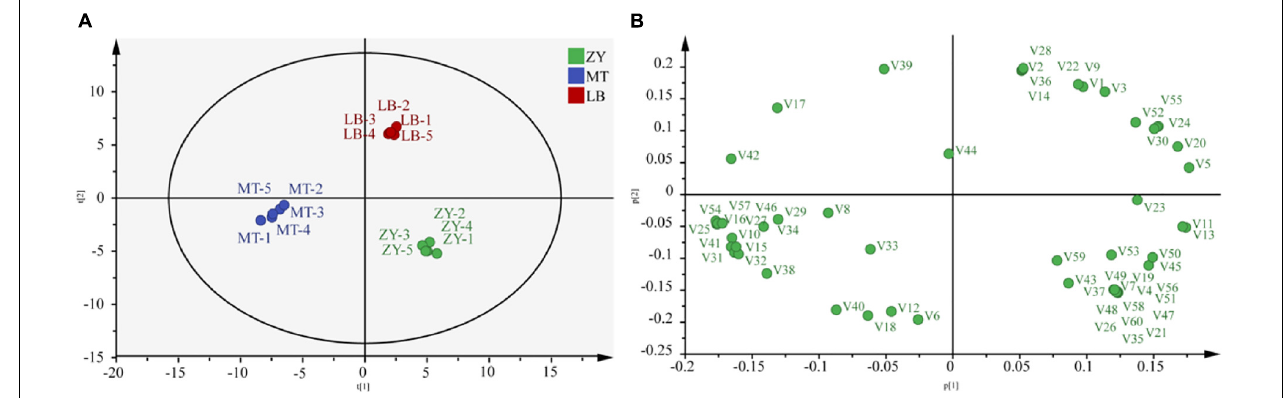
FIGURE 3 | (A) Principal component analysis (PCA) and load diagram (B) results for flavor metabolites contents in SZR